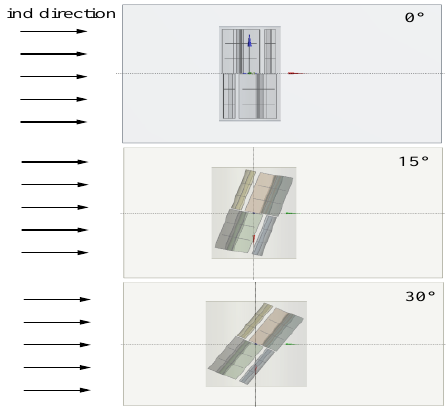
Figure 19. Wind turbine deflection